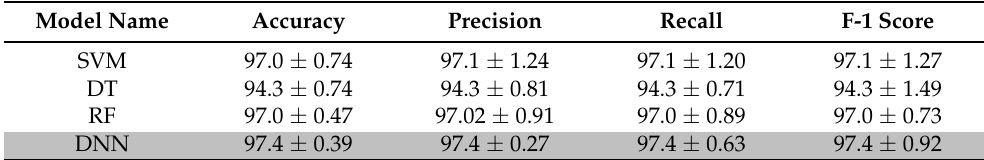
Table 9. Models’ performance for binary